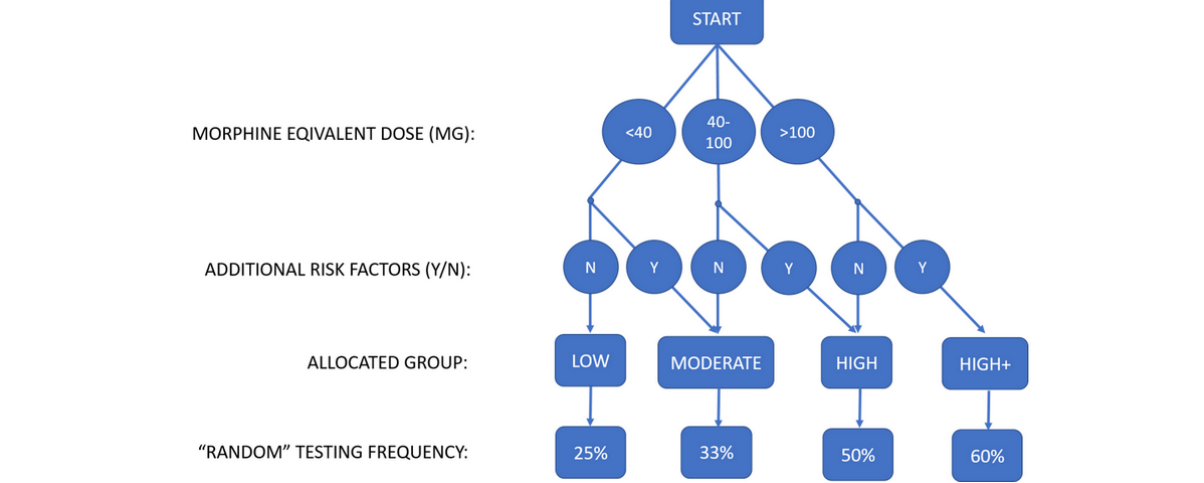
Figure 2. Risk category allocation and the corresponding pre-set chance that the UDT Randomizer tool will request UDT during a patient